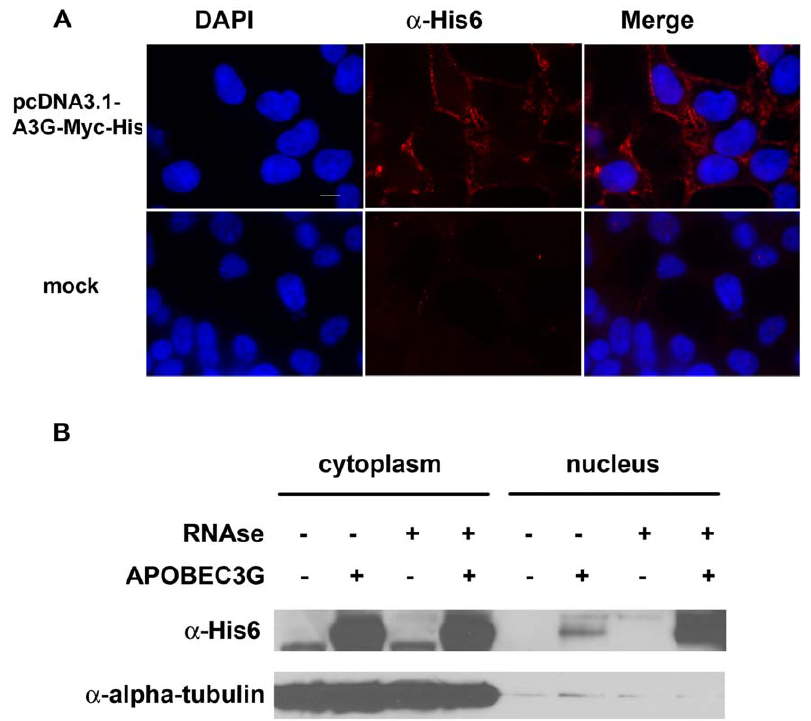
Figure 8. Nuclear-cytoplasmic distribution of A3G. (a) HEK293T cells transiently transfected with APOBEC3G-expressing plasmid were fixed and stained with DAPI to visualize nuclei and anti-His 6 antibodies to visualize APOBEC3G. (b) Western-blot analysis of nuclear and cytoplasmic fractions of HEK293T cells overexpressing A3G. See Materials and Methods for details.